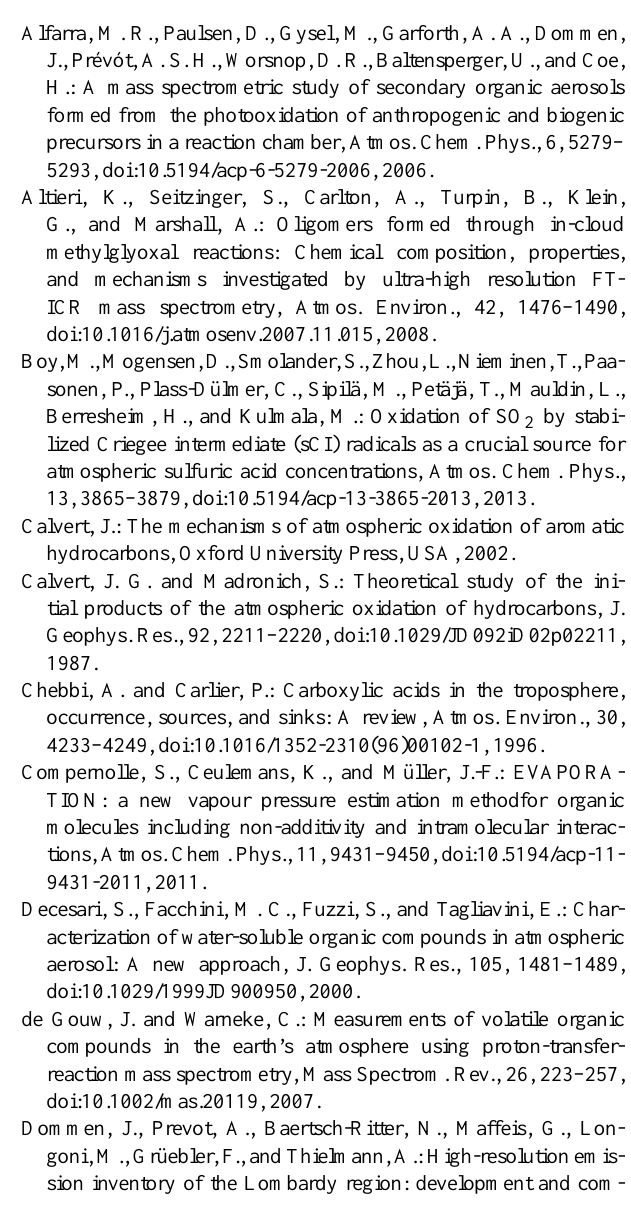
Figure 10. No partitioning of acetic acid onto the aerosol is ob- served after injection of a large amount of acetic